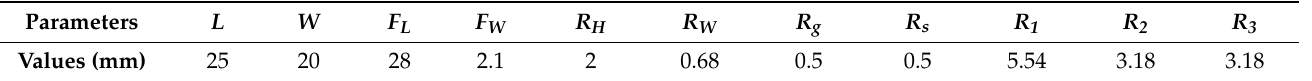
Table 2. Curve-feed design parameters.